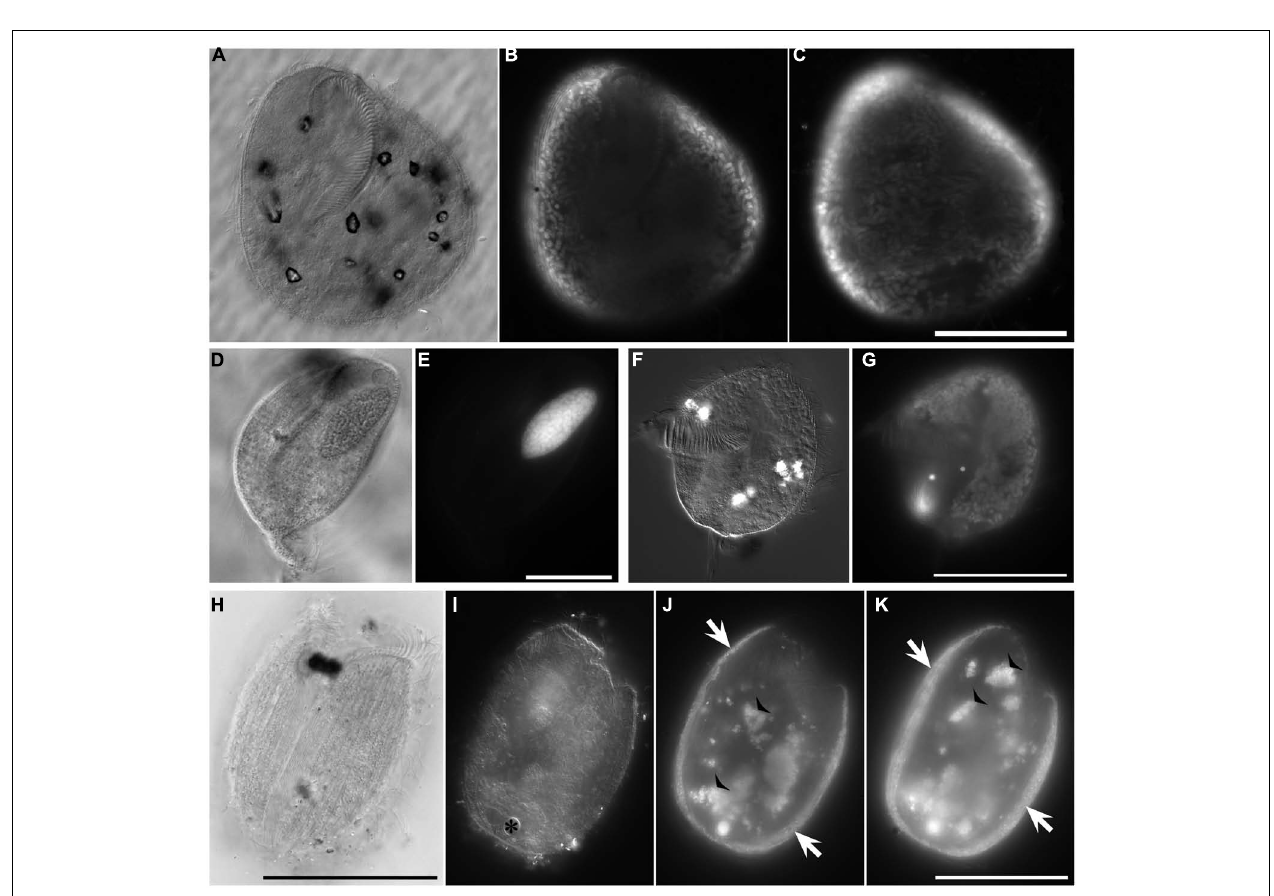
FIGURE 6 | Light micrographs of protists from Discovery DHAB. (A–C) Ciliate from 609 c14 (mid-halocline). (A–C) Paired images showing DIC (A,B) and epifluorescence (C) of DAPI staining. Note the nucleus (C) and lack of abundant prokaryotic associates (C) .